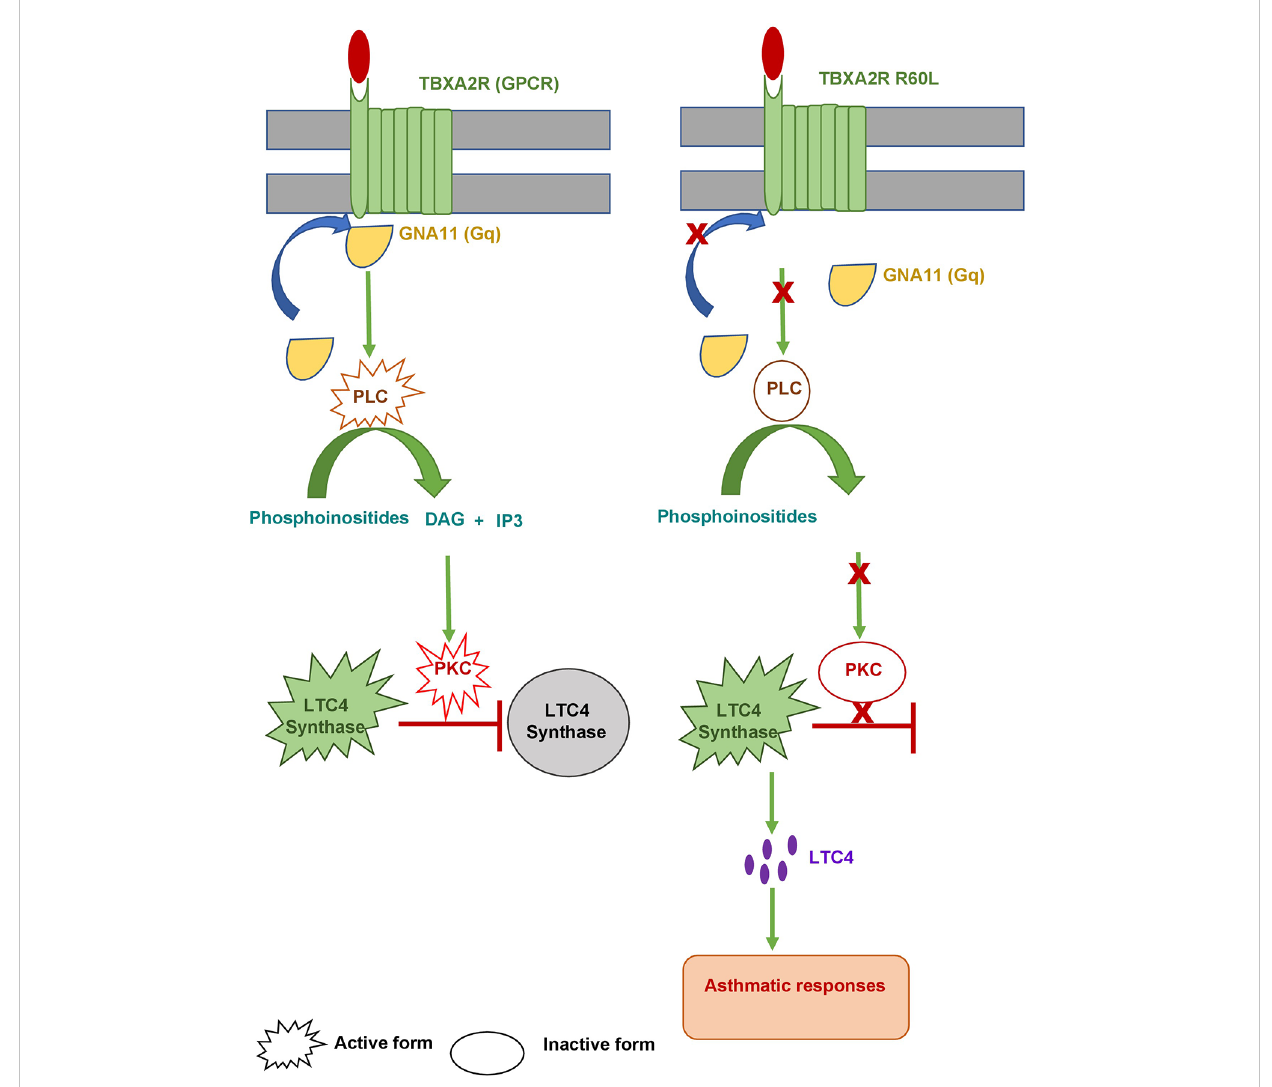
FIGURE 9 Model for asthmatic regulation via . TBXA2R. The left panel shows wild type TBXA2R prevents asthmatic responses by converting active LTC4 Synthase into an inactive one. The right panel shows how a mutation (R60L) in TBXA2R causes an asthmatic